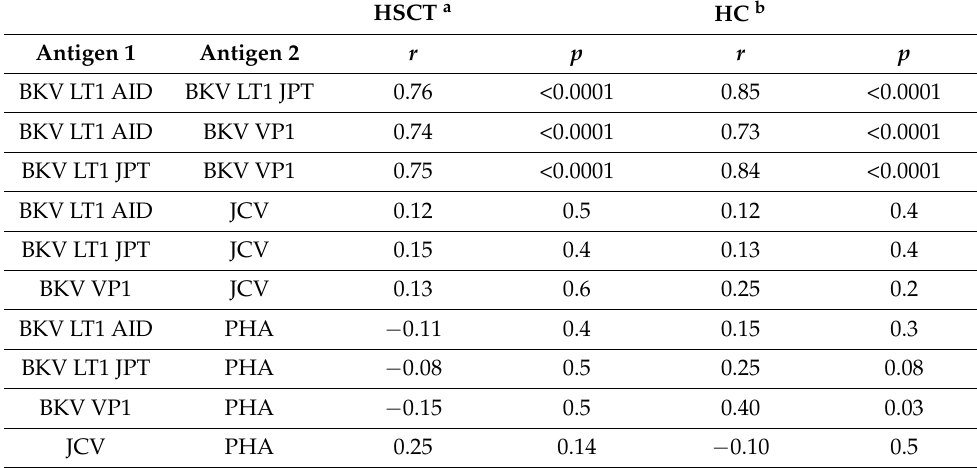
Table A2. Spearman correlation analysis of ELISpot responses towards peptide pools of large T (LT) from AID and JPT, of BKV viral protein (VP) 1, and of JC virus